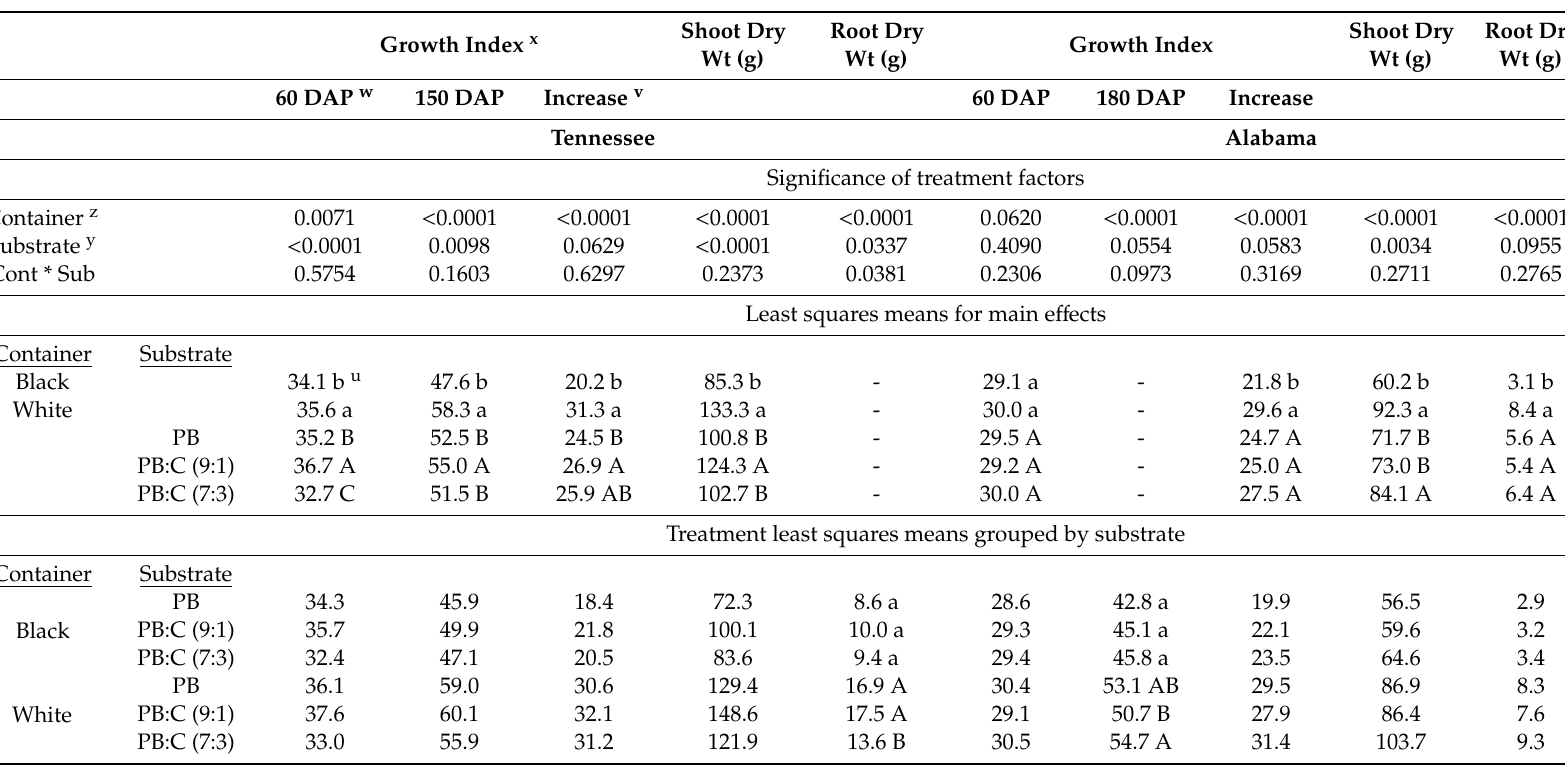
Table 4. Plant growth index ( n = 12), growth index increase, and dry weight (shoot and root) ( n = 6) of “Green Giant” arborvitae grown in di ff erent types of containers and substrates in Tennessee (McMinnville) and Alabama